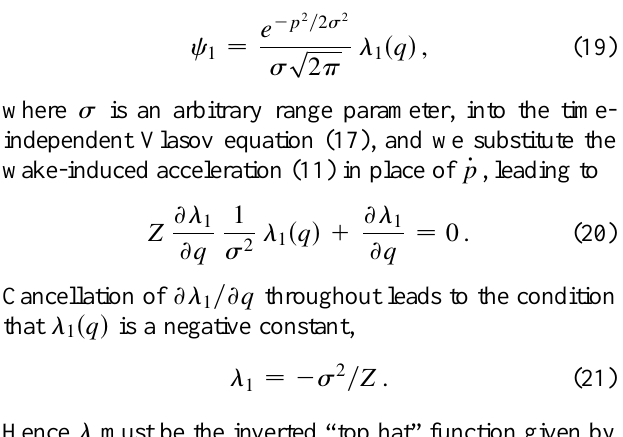
FIG. 33. Waterfall plot of line density, 4500 turns. Two holes split, 10 13 protons, 2.2 3 10 5